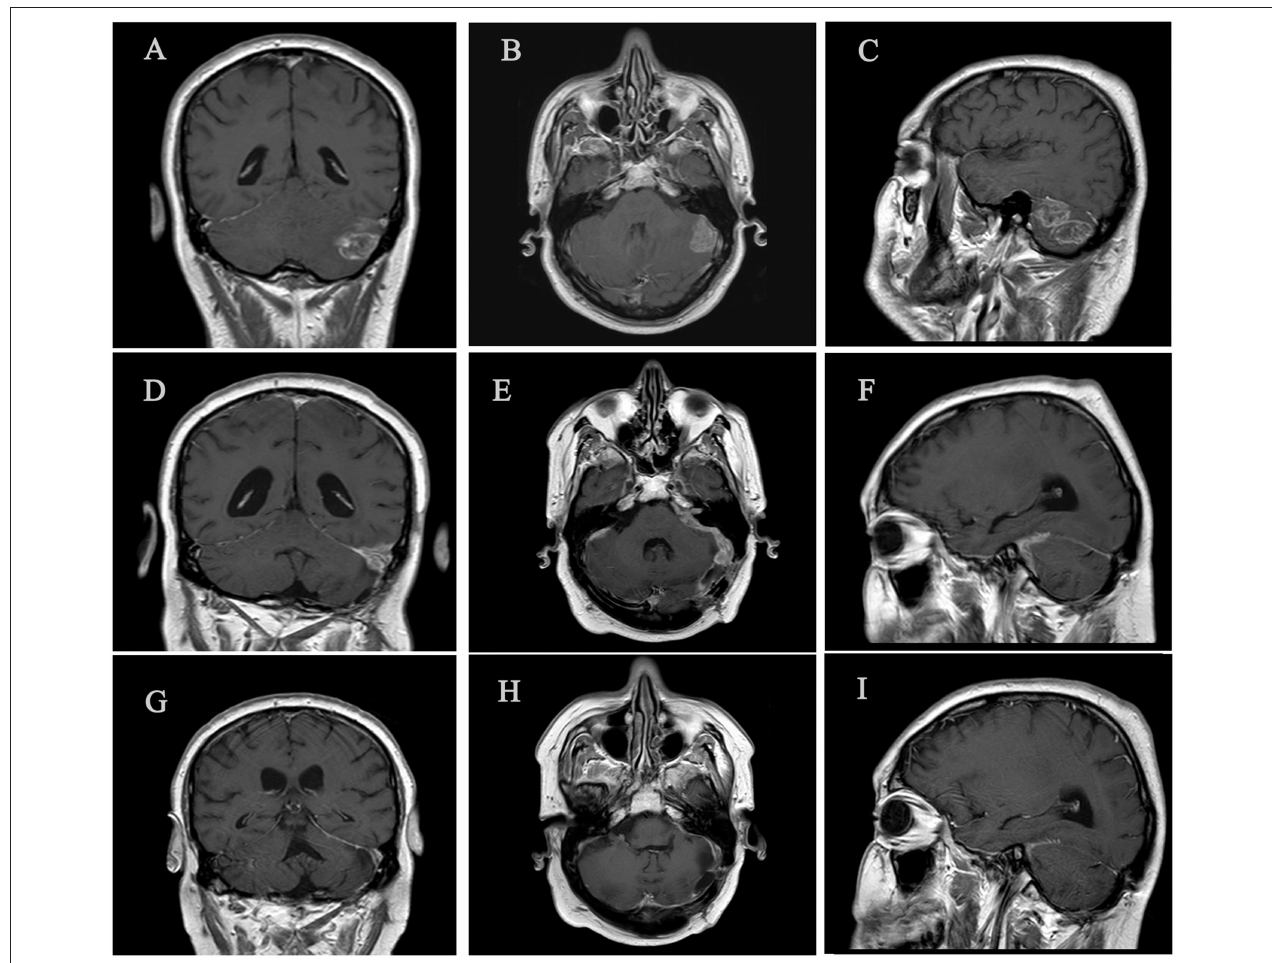
FIGURE 1 | Three significant time points of brain disease. (A–C) Left cerebellar metastasis prior to brain surgery (January 2015). (D-F) Leptomeningeal metastasic disease, predominantly left cerebral hemisphere (September 2015). (G–I) Complete brain response with no evidence of leptomeningeal involvement after 3 months of nivolumab treatment (December